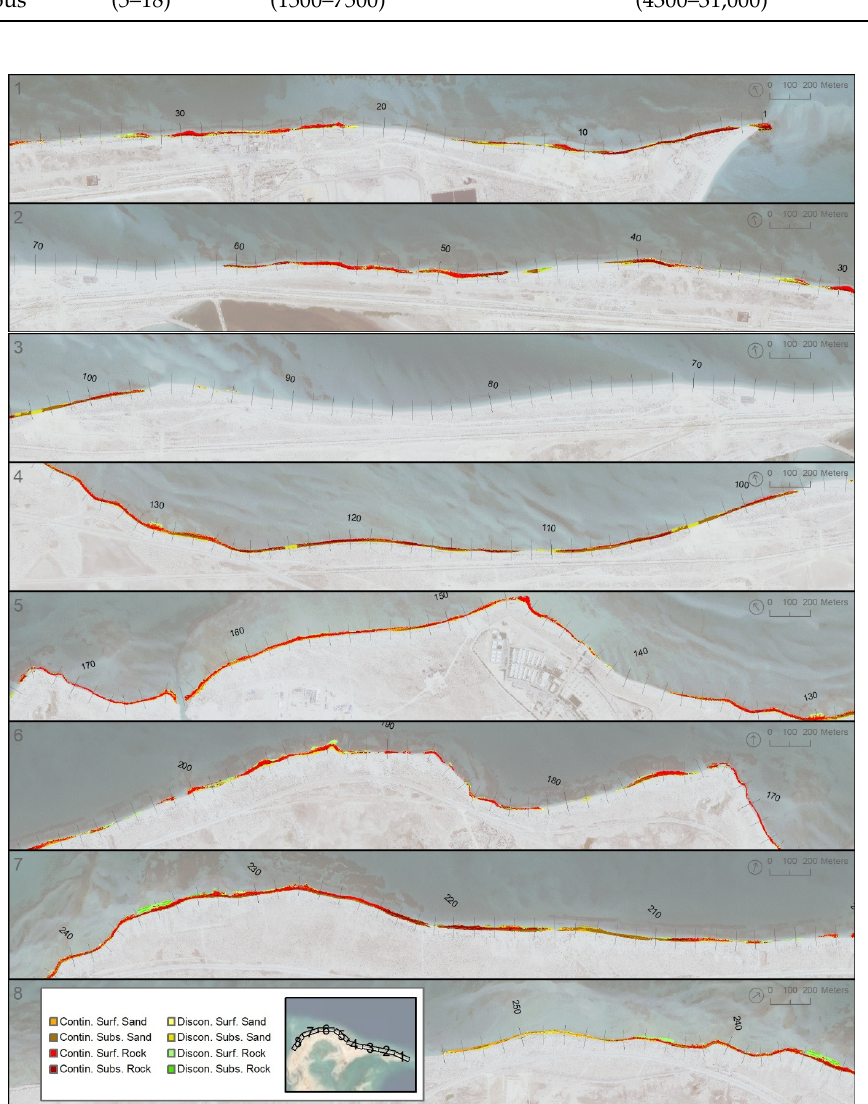
Figure 4. Maps of model-derived intertidal oil location and type categories across the project area. Labels at intervals of 10 transects. Subfigures labeled 1 through 8, sequentially from east to west.